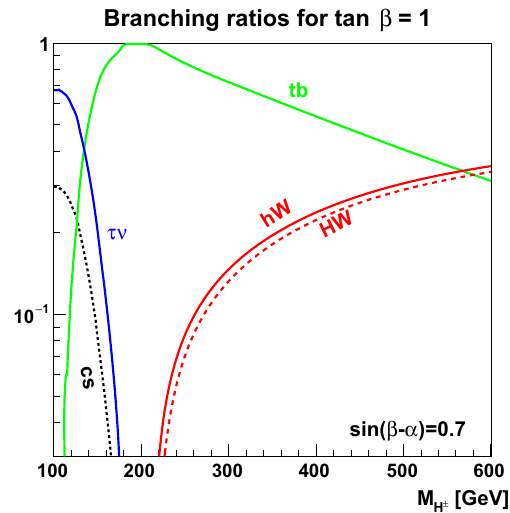
Fig. 3 Charged-Higgs branching ratios vs. M H ± , for tan β = 1 and sin (β − α) = 0 . 7. Here, two light neutral Higgs bosons h and H (125 and 130 GeV) are